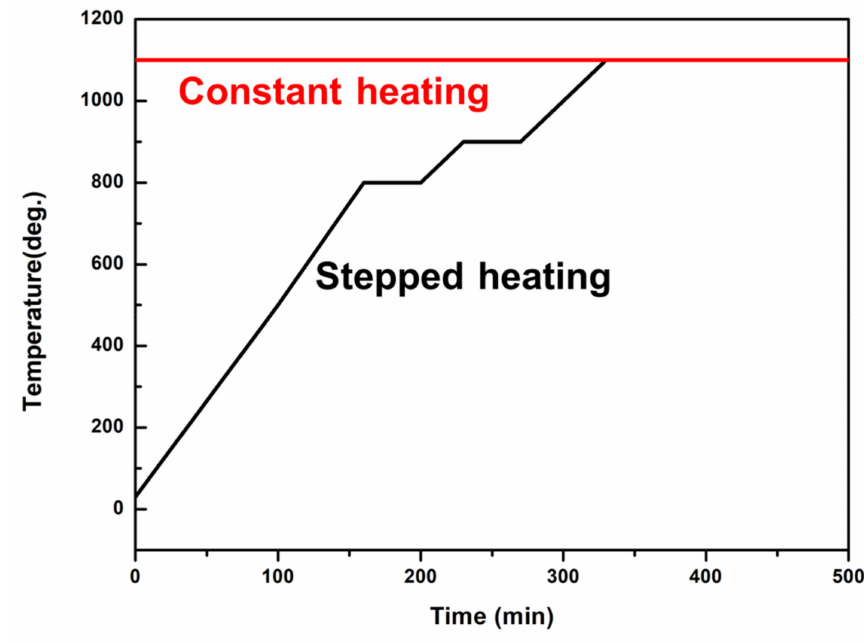
Figure 1. The heating curve of the NiCrAlHf bond coat